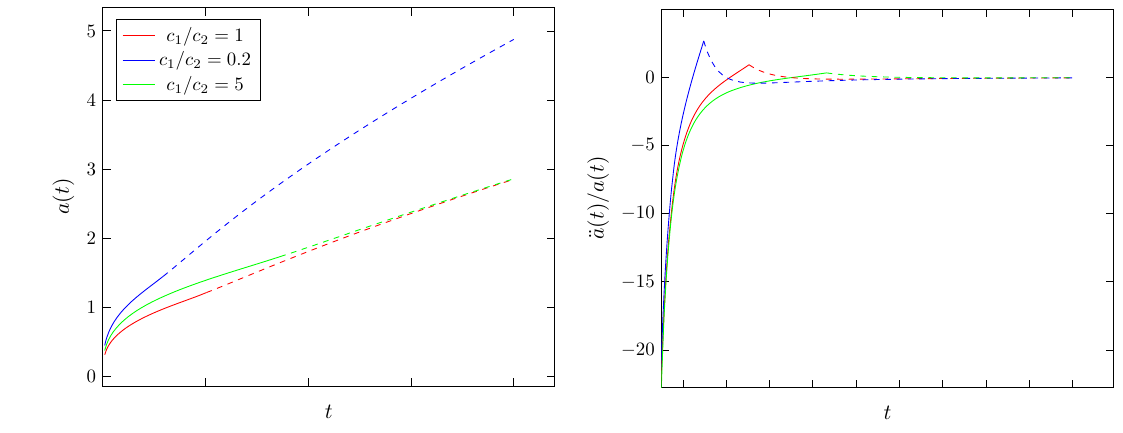
Fig. 1 The scale factor (left) and acceleration ¨ a / a (right) as function of time for three values of c 1 / c 2